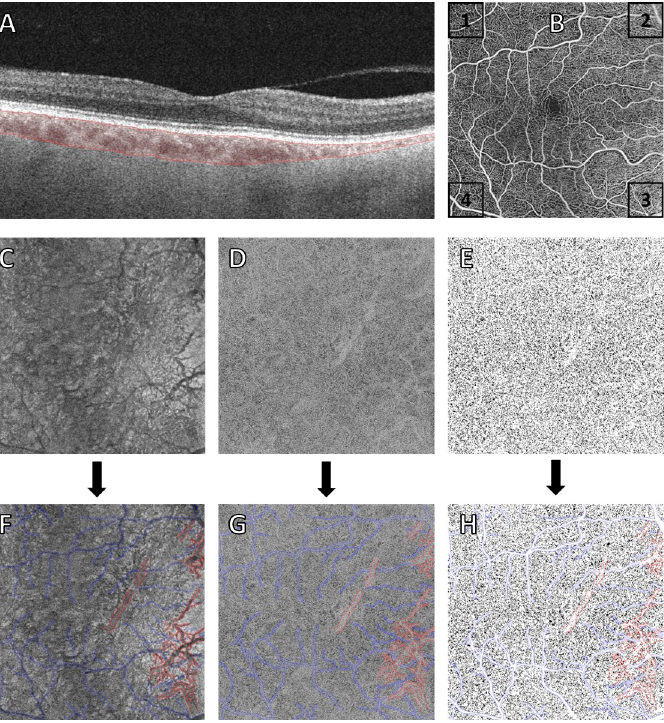
Fig 2. Visualization of choroidal thickness (CT) and en-face choriocapillaris (CC) images throughout different processing steps in 6x6mm scans of a healthy right eye. (A) CT (marked in red) in a B-scan showing a thickness decrease towards the nasal half of the image. (B) Layout of the four squares in a right eye. (C-E) en-face images of the CC-slab, showing the structural information scan (C), the signal compensated CC scan (D) and the binarized version of the signal compensated CC scan (E). The bottom set of images (F,G,H) shows the projection of the superficial plexus, marked in blue and large choroidal vessels (LCV) marked in red on the images above. Additionally, in the last image (H) the superficial plexus was masked for better